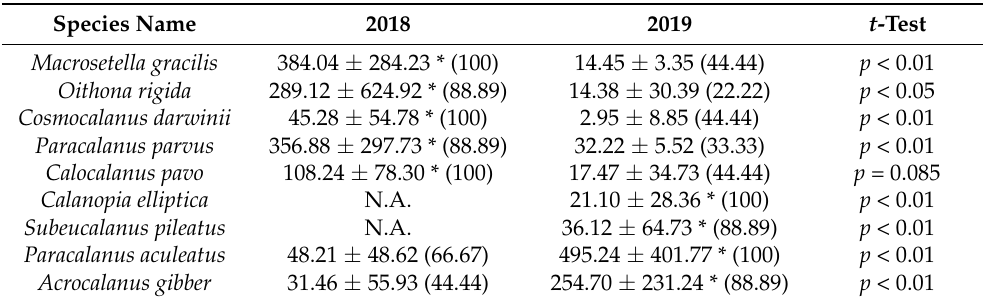
Table 2. Mean abundance, occupancy, and comparative results of mean abundances using t -test for indicator species recorded during the sampling cruises in 2018 and 2019. The numbers in parentheses represent the occupancy (%). * Indicates the indicator species during that cruise. N.A. means not